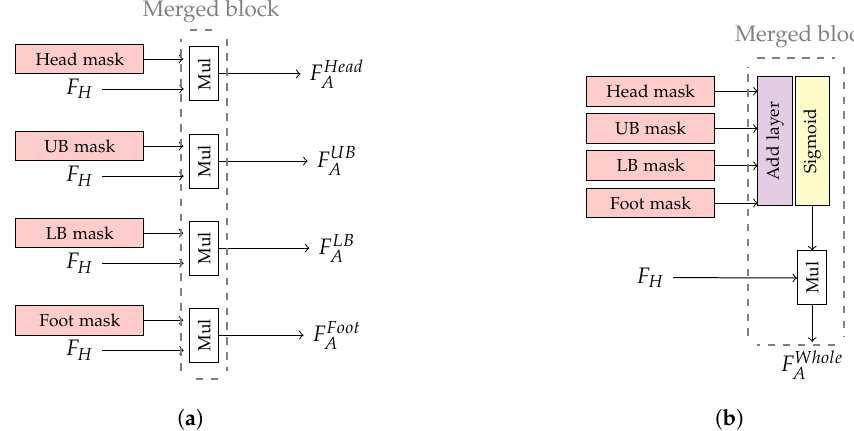
Figure 5. The illustration of human-part attention module for ( a ) separated and ( b ) single